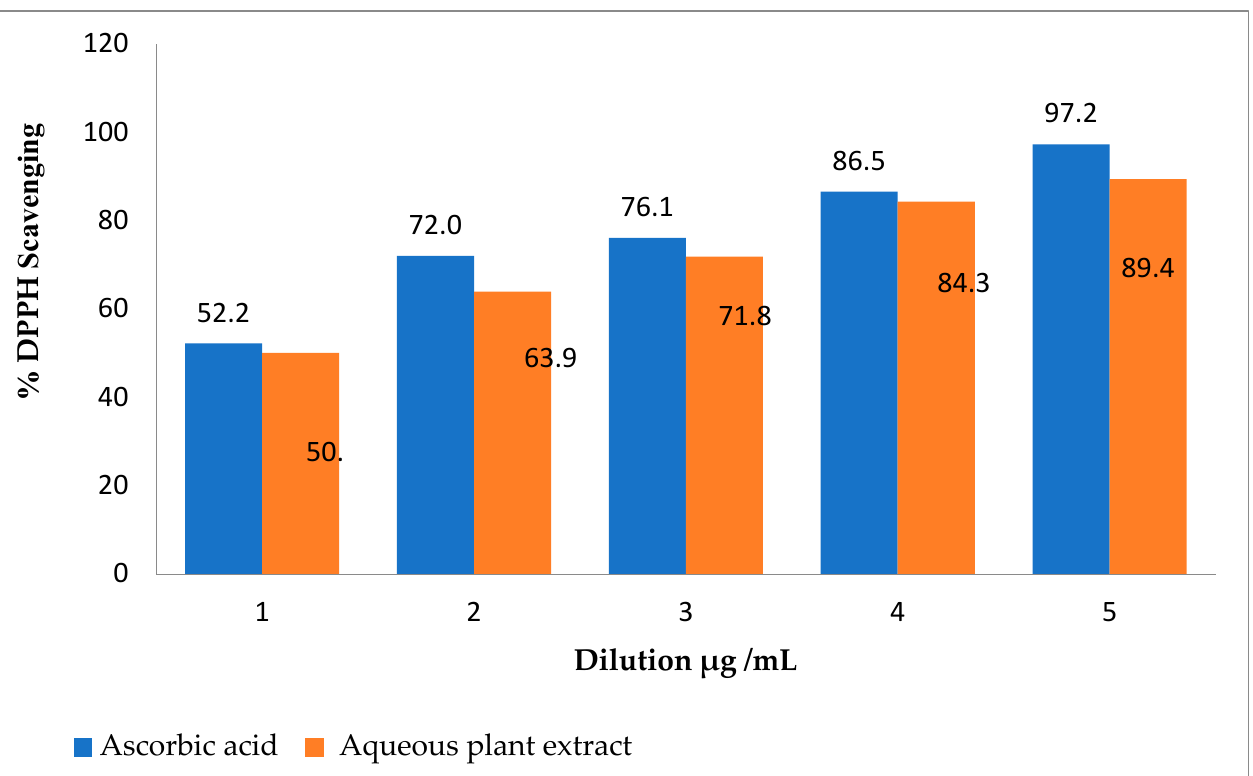
Figure 1. Antioxidant activity of S. emodi extract against DPPH radicals.